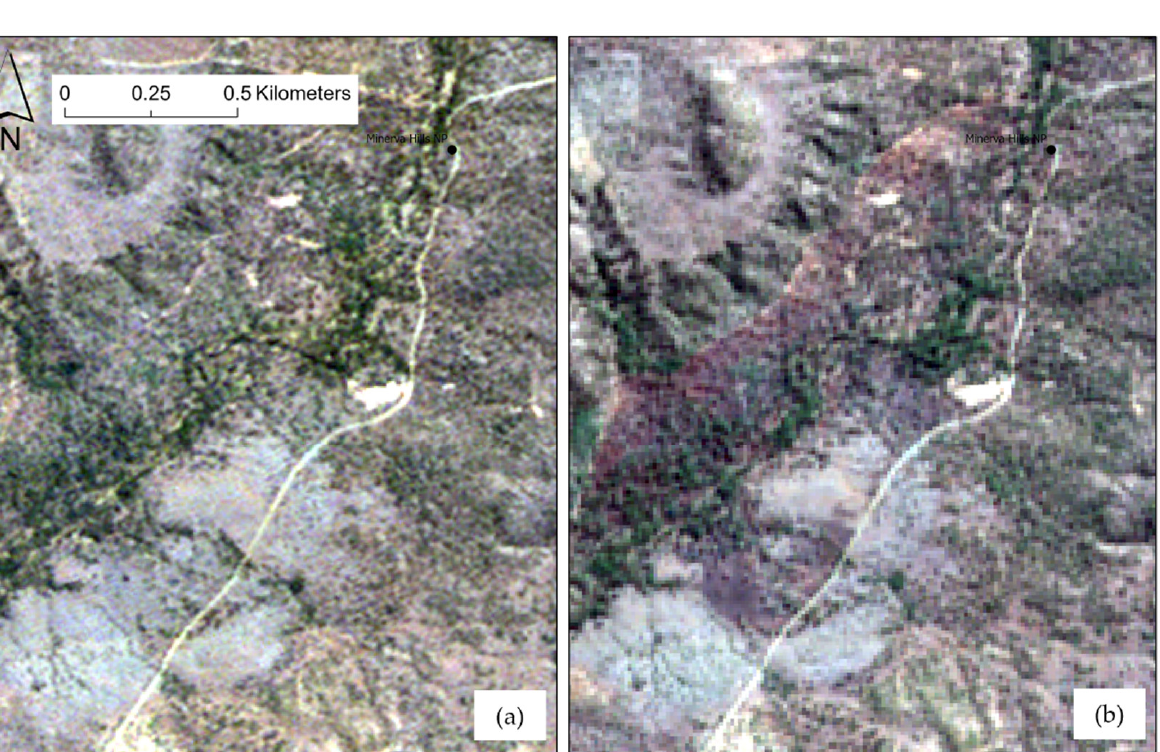
Figure A1. Comparing the subjective map user visual acuity of Sentinel-2 (S2) images (10 m spatial resolution) and RapidEye (RE) images (3 m) for an area within the Minerva Hills National Park (located Northwest of the Queeensland, Australia town of Springsure: lattitude −24.12, longitude 148.09): ( a ) RE true-colour 25 September 2017, ( b ) S2 true-colour 30 July 2018; ( c ) RE Normalised Difference Vegetation Index (NDVI); and ( d ) S2 NDVI.